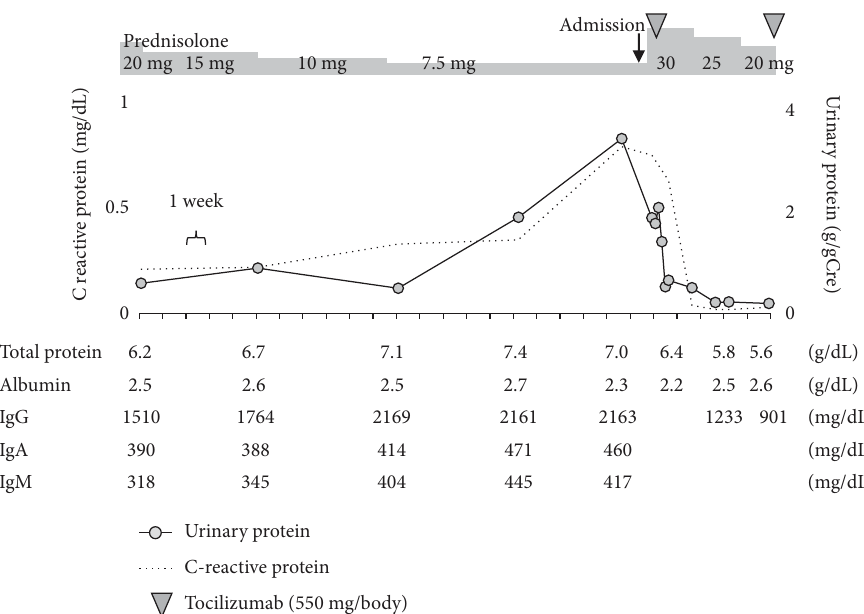
Figure 5: Subsequent clinical course of the patient. In the case, proteinuria was successfully controlled for 6months with corticosteroid monotherapy after discharge from our hospital. During the process of tapering prednisolone, serum IgG titer began to increase, and polyclonal gammopathy appeared. Te patient was referred to another hospital for induction of anti-IL-6 therapy, tocilizumab. Te disease markers of MCD such as serum IL-6 and plasma vascular endothelial growth factor were not